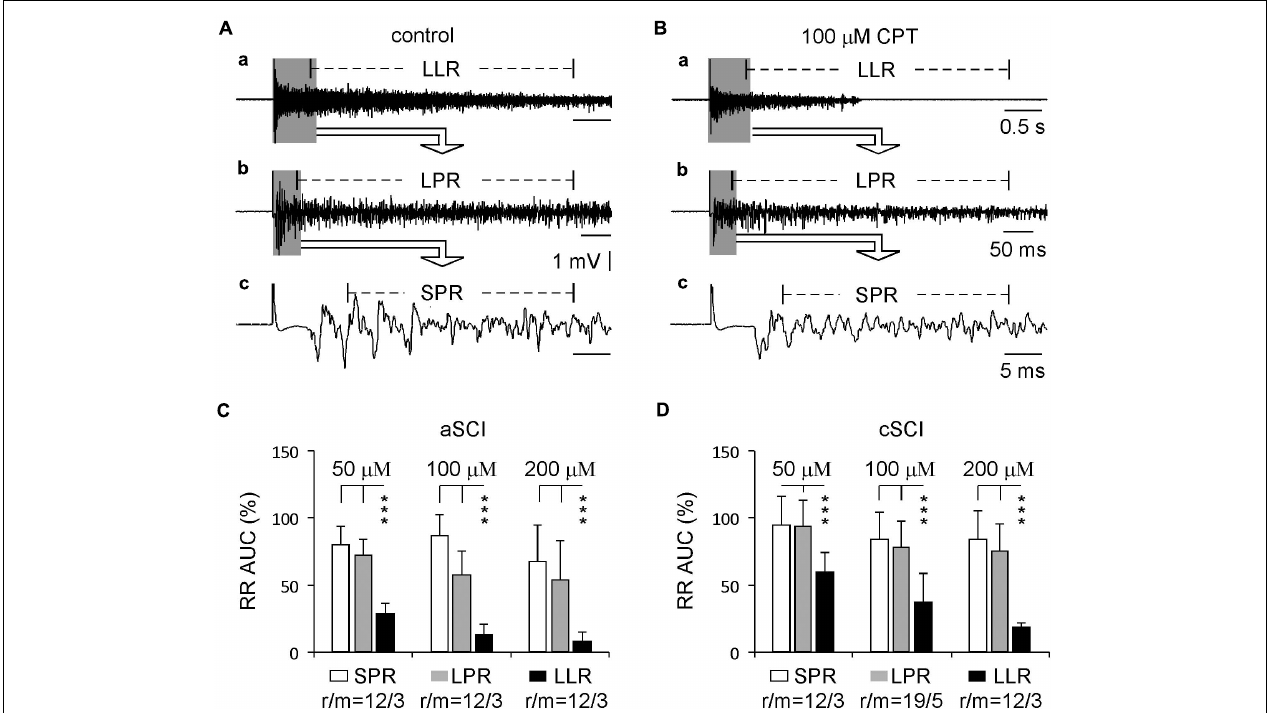
FIGURE 4 | Comparison between different components of root reflexes. (A) Sample recordings before CPT application in a cSCI mouse display root reflexes with different components: LLR (a), LPR (b), and SPR (c). (B) Sample recordings from the same mouse show the inhibitory effect of CPT on these root reflexes (a–c). (C) Histograms illustrate the inhibitory effects of CPT on the root reflexes in aSCI mice. The data were analyzed by unbalanced two-way ANONA (drug concentrations: p = 0.0040; components of root reflexes: p = 4.72 × 10 − 25 ) and by post hoc Tukey test (*** p < 0.001). (D) Histograms display CPT’s effects on the root reflexes in cSCI mice. The data were analyzed with the same statistics as in (C) (drug concentrations: p = 3.58 × 10 − 6 ; components of root reflexes: p = 4.38 × 10 − 23 ; unbalanced two way ANOVA; post hoc Tukey test: *** p < 0.001). r/m represents root/mouse; the data were collected in the same experiments as used in Figure 2